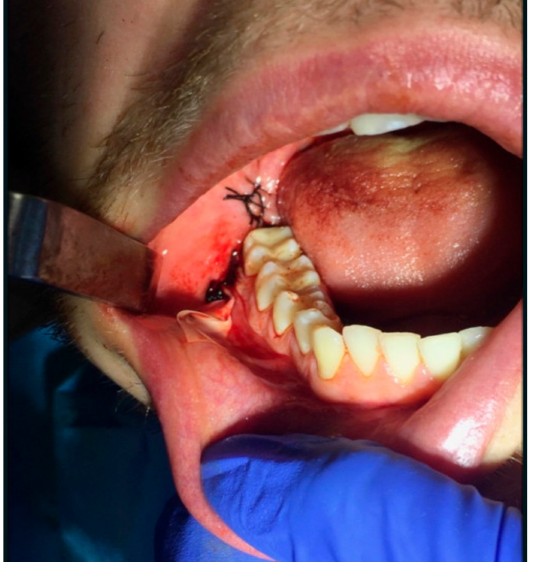
Figure 2. Latex flat drain sutured into a release incision in the oral